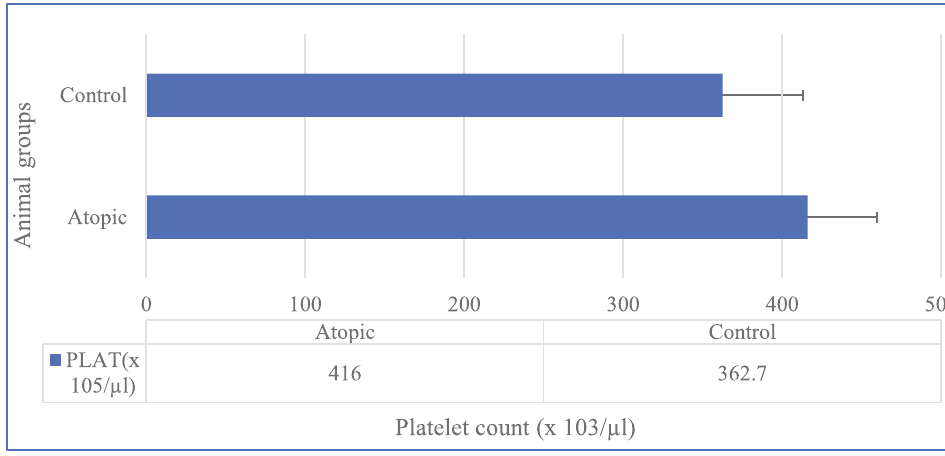
Fig. 5. Mean platelet count (x 10 3 /µl) in atopic animals and healthy controls table 5. Serum biochemical values in atopic animals and healthy controls